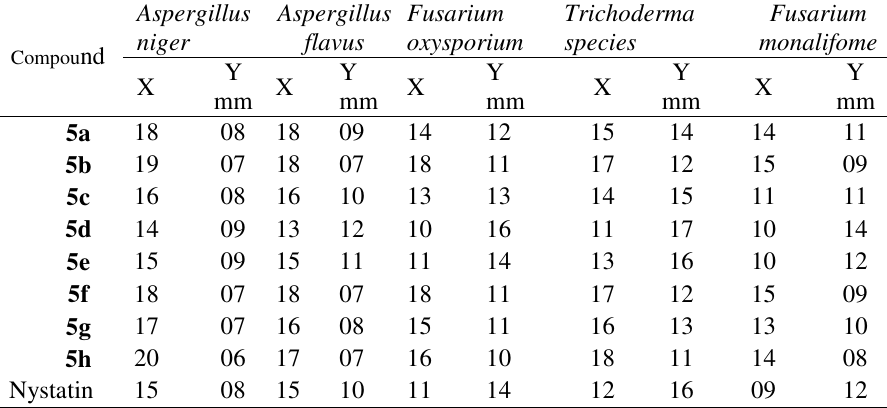
Table 2 . Minimal inhibitory concentration in µg mL -1 [X] and Inhibitory zone in (diameter) mm [Y] of the synthesized compounds against tested fungal strains by micro dilution method and disk diffusion method respectively